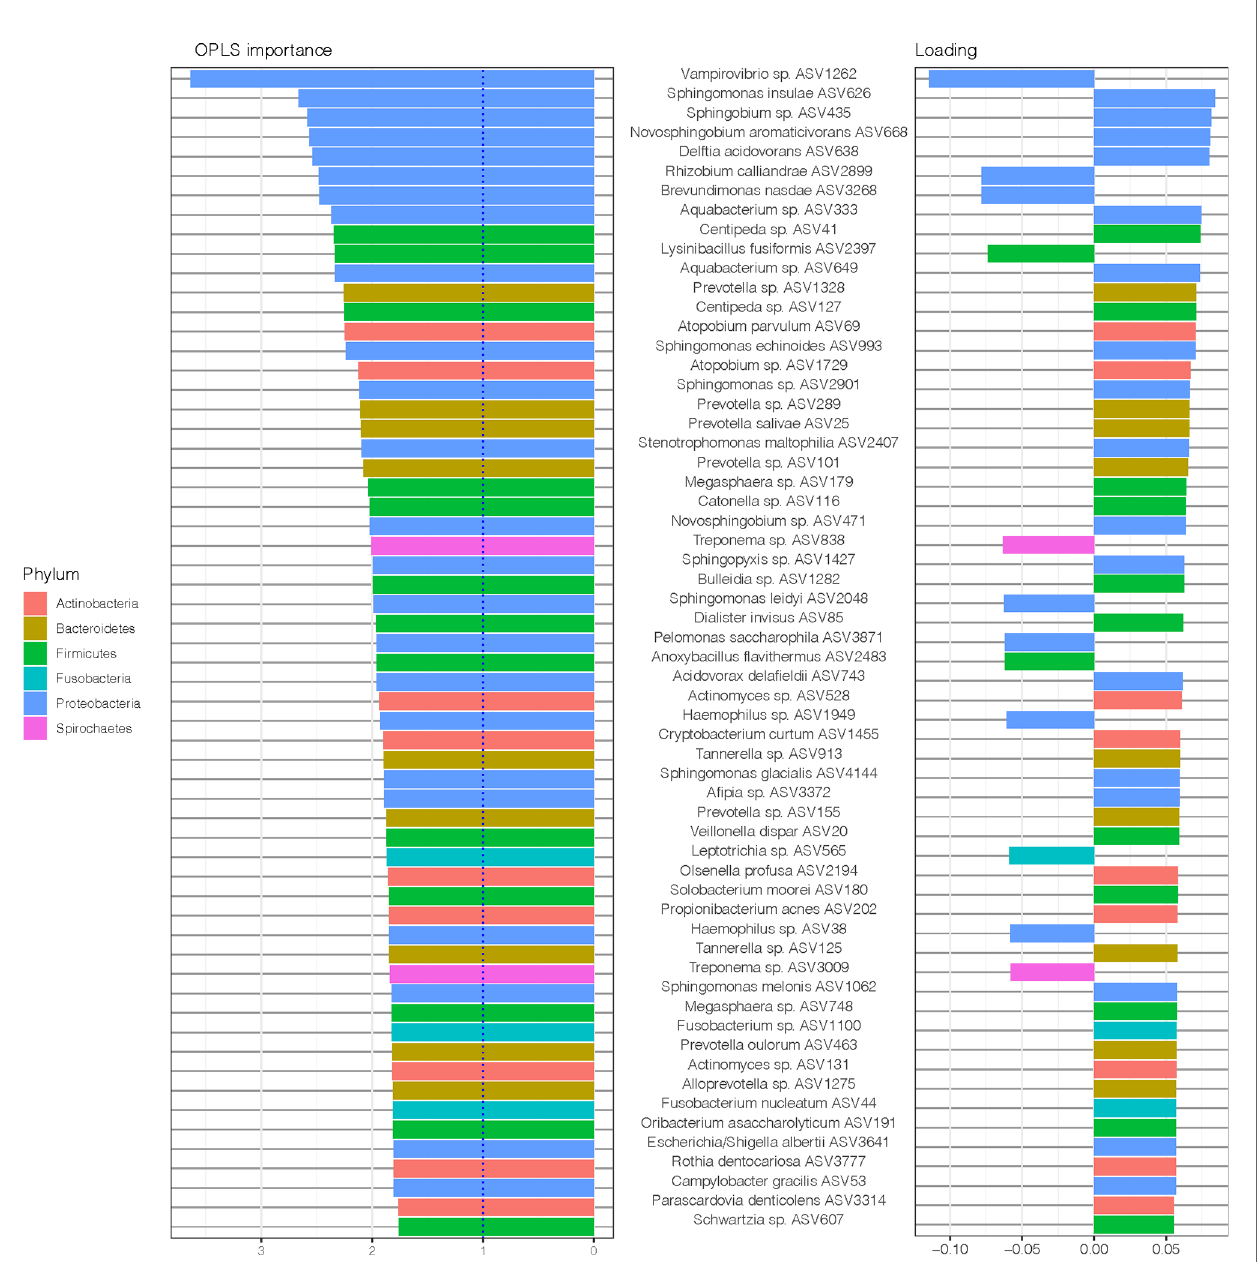
FIGURE 4 | Amplicon sequences variants (ASVs) identi fi ed by Orthogonal Partial Least Squares Discriminant Analysis (OPLS-DA) analysis. In OPLS-DA, a single component serves as a predictor for the class. The sixty most important variables (with VIP > 1) for the classi fi cation of saliva samples from patients with and without RA are shown. The variable loading on the predictive component is shown (positive = discriminatory direction RA, negative = discriminatory direction non-RA). The lowest annotated taxonomic rank is shown for each ASV as well as the ASV IDs used for the